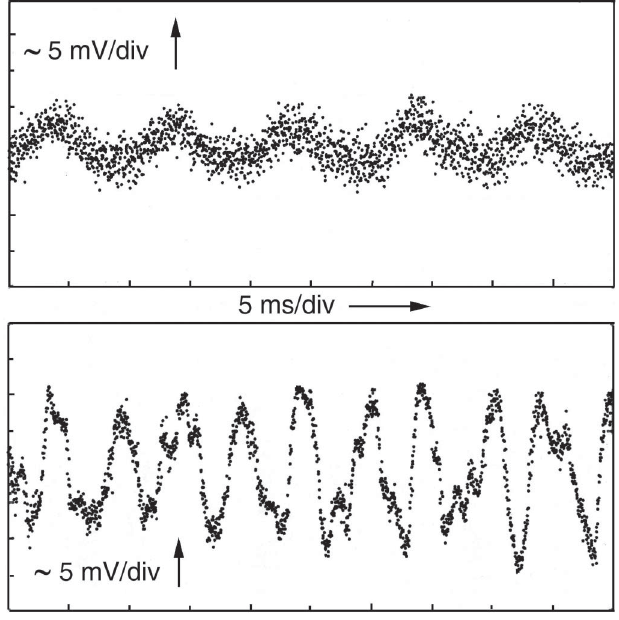
FIG. 2. Microphonic noise in an ANU LINAC cryostat. The top trace is the frequency error signal ( 0 : 25 Hz = mV ). The rms frequency background noise is about 1 Hz. The bottom trace is the same signal while the slow mechanical tuner is operating. The rms frequency noise has increased to 2.3